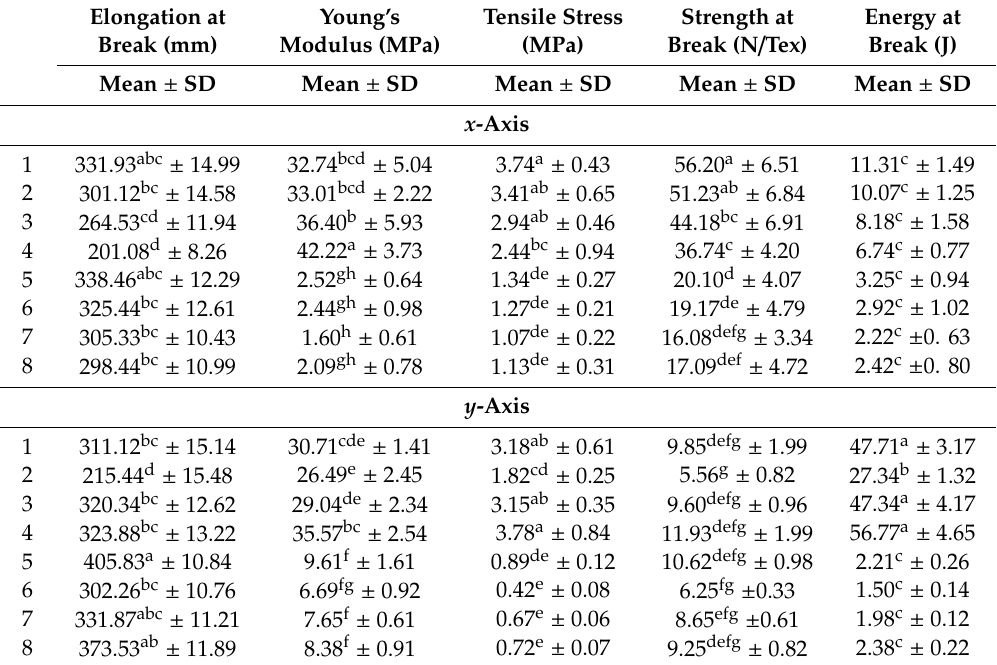
Table 1. Mechanical properties of the composite films along the x -axis and y